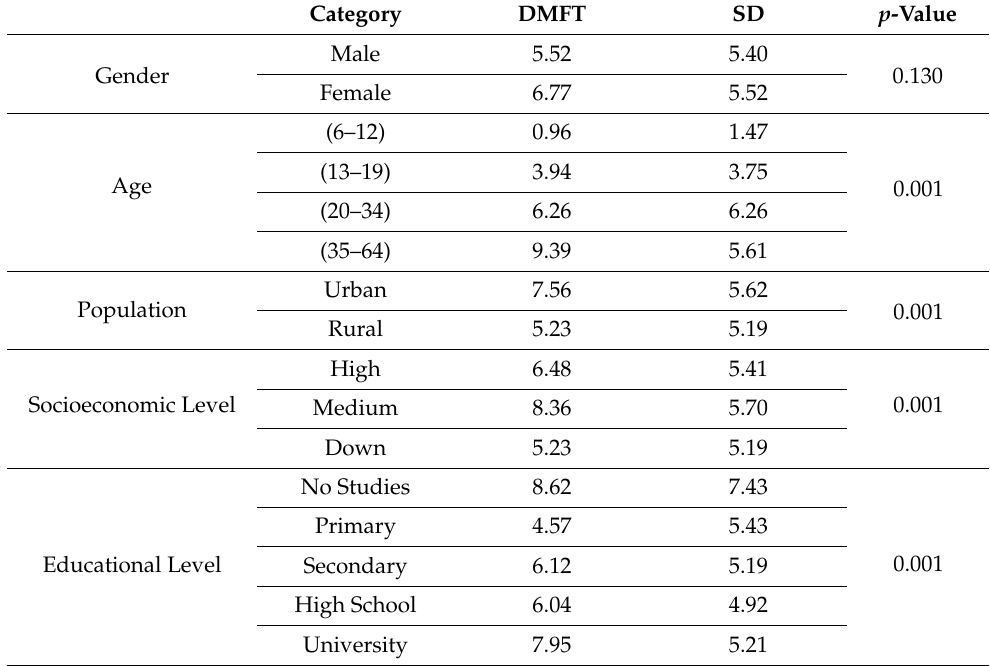
Table 11. Relationship of socio-demographic variables with the DMFT index. Significance for p -value <